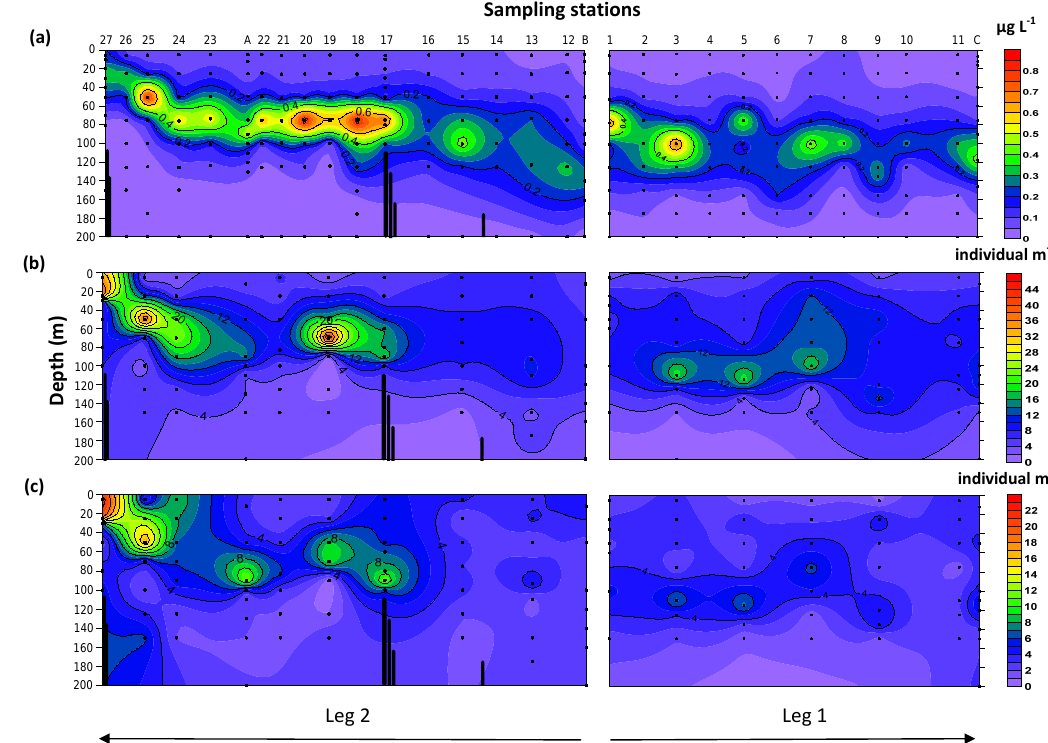
Fig. 4. Spatial distribution of chlorophyll- a concentration (a), copepods nauplii (b) and small copepods (c) within the upper 200 m layer across the Mediterranean Sea. Bottom depth in black.